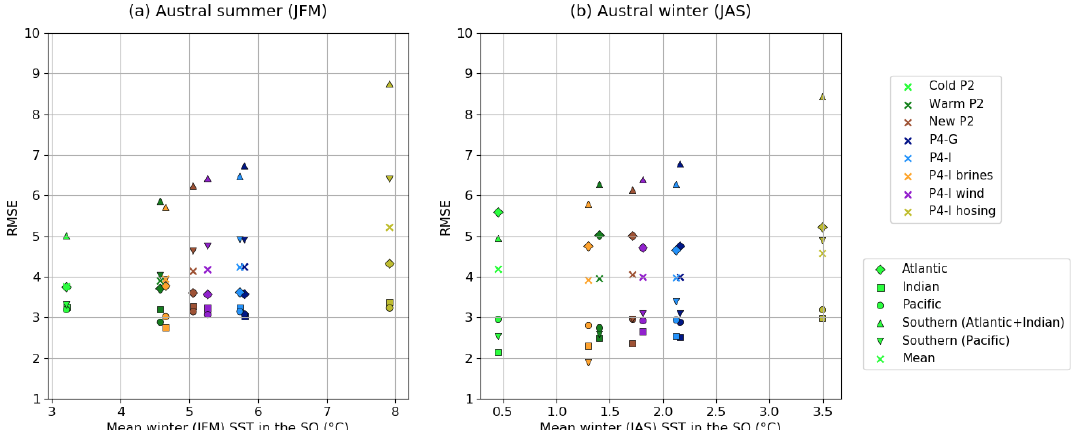
Figure 3. Relationship between the model–data agreement and the overall temperature of the Southern Ocean, in austral summer (a) and winter (b) . The mean value of the Southern Ocean SSTs (averaged up to 36 ◦ S) of each simulation is plotted on the x axis. The y axis represents the root mean square error computed using the SST data from MARGO Project Members (2009), which is small when the agreement is good. This value was computed for each basin and each simulation, as shown by the marker style and color,